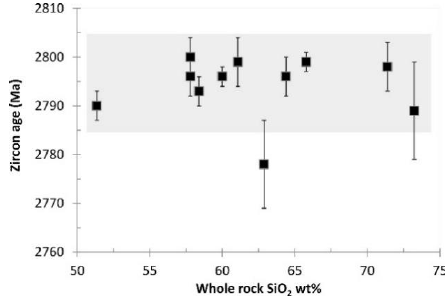
Figure 9. Age versus SiO 2 for the dated samples that are presented in this study. Error bars are on a 2 sigma level. The shaded area reflects the interpreted minimum age of the intrusion, ca. 2785–2805 Ma.